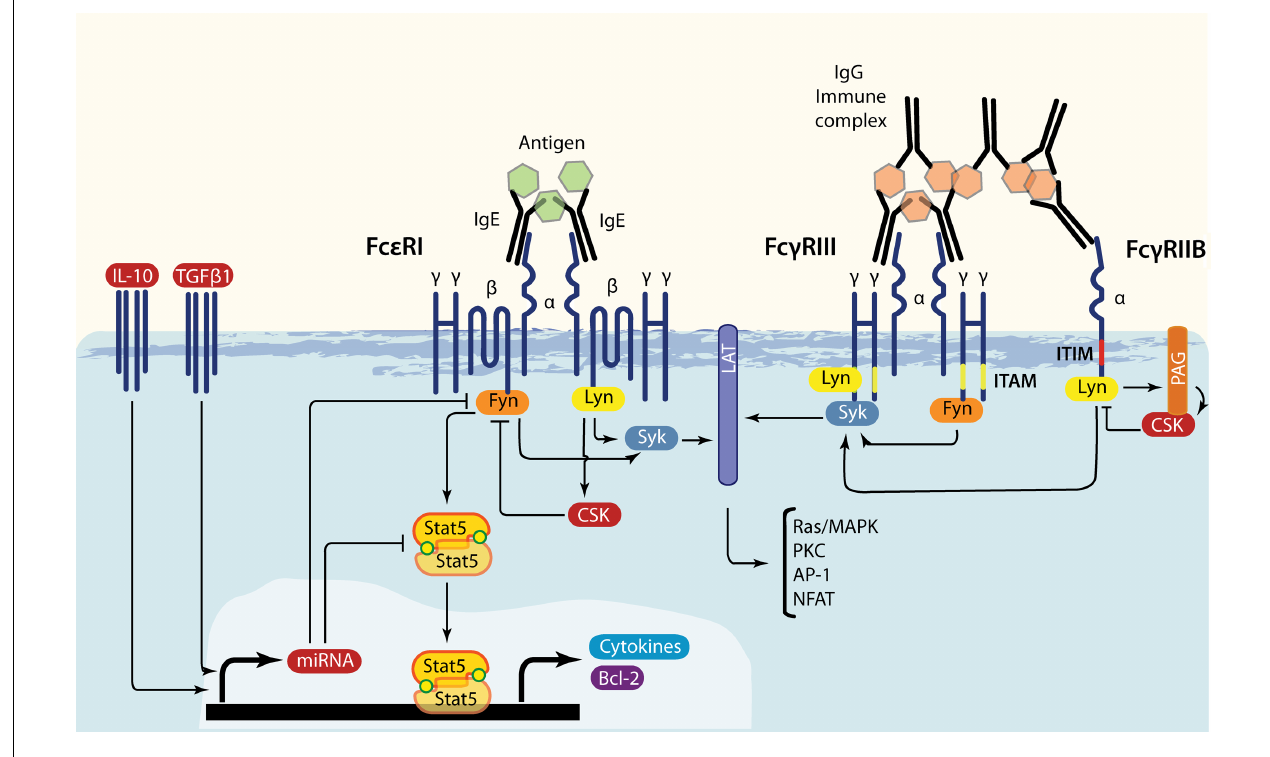
recruitment via SH2 interactions with phosphorylated Cbp/PAG. Additionally, Fyn stimulates the PI3-K axis. Under Fc ε RI-driven signaling, Fyn activates STAT5, transcription factors that are required for mast cell survival (STAT5A) and cytokine production (STAT5B). Regulatory cytokines such as IL-10 andTGF β 1 can inhibit Fyn and STAT5 production, possibly through the induction of specific miRs.